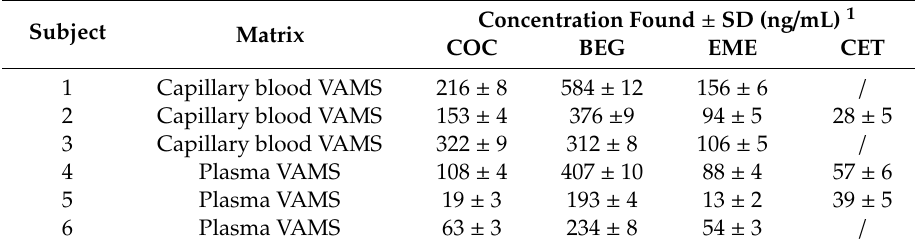
Figure 3. LC-MS / MS chromatogram of a plasma VAMS sample from a COC and ethanol user: 1—EME (12 ng / mL); 2—EME-D 3 (IS, 50 ng / mL); 3—BEG (196 ng / mL); 4—BEG-D 3 (IS, 50 ng / mL); 5—COC (18 ng / mL); 6—COC-D 3 (IS, 50 ng / mL); 7—CET (40 ng / mL); 8—CET-D 3 (IS, 50 ng / mL). Table 4. Analyte level results in real VAMS